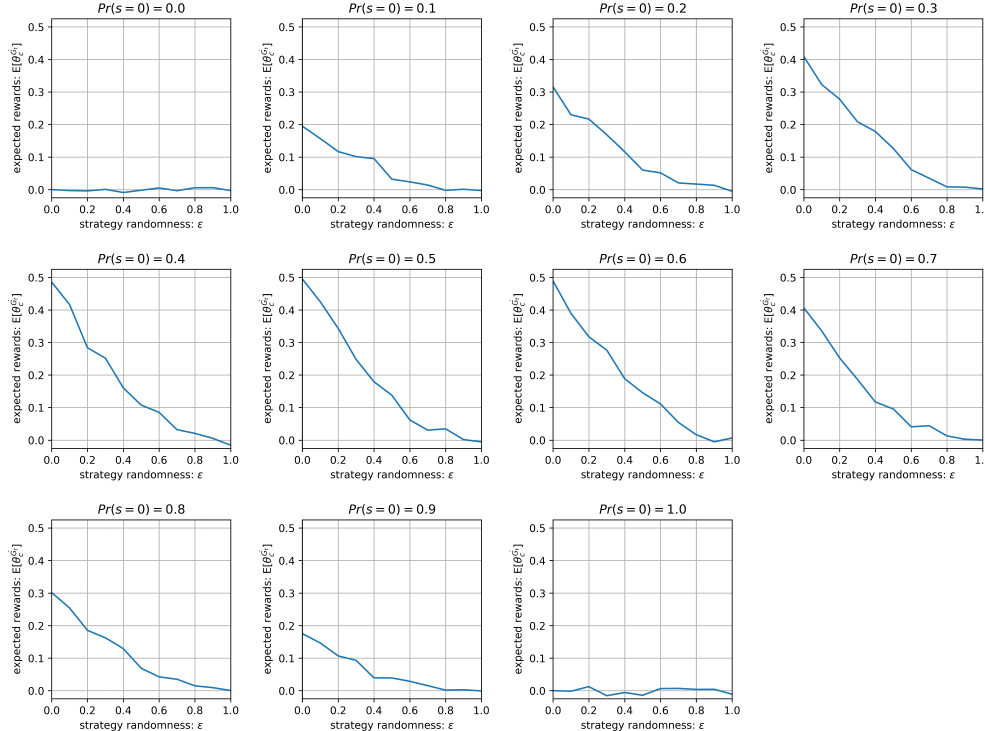
(cid:104) (cid:105) ˙ G t c Fig. 5. The second experiment computes E , which varies depending on strategy randomness ε θ and signal distribution Pr ( s = 0 ) in G t . 11 graphs for 121 { 0 . 0 , 0 . 1 , ··· , 1 . 0 }×{ 0 . 0 , 0 . 1 , ··· , 1 . 0 } cases (cid:104) (cid:105) ˙ G t c reveal that E is maximized when all curators select the truthful strategy ( i.e. , ε = 0 . 0), except θ the Pr ( s = 0 ) = 0 . 0 or 1 . 0 case. This result is consistent with strong truthfulness , which can elicit informative reports from assigned curators in CitedTCR